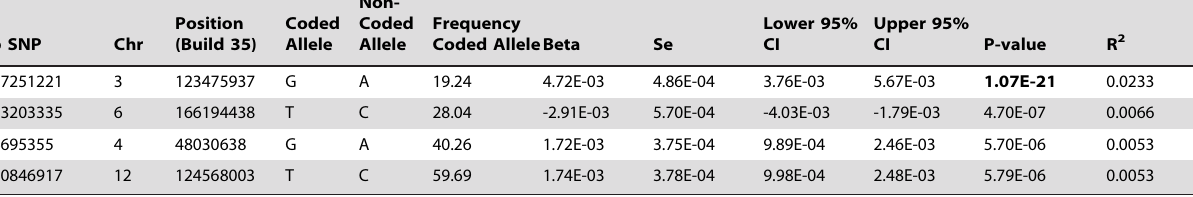
Figure S2 Study-specific quantile-quantile plots. Shown are observed -log 10 p-values plotted against expected -log 10 p-values resulting from each single study after applying genomic control correction. The study-specific l -values were l = 1.0139 (CoLaus),